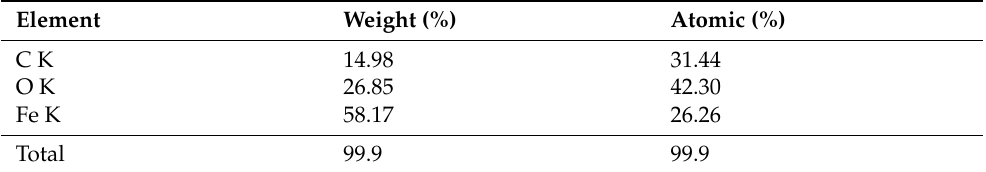
Table 1. Elemental composition of Fe 3 O 4 /Gr nanocomposite from SEM-EDX analysis.